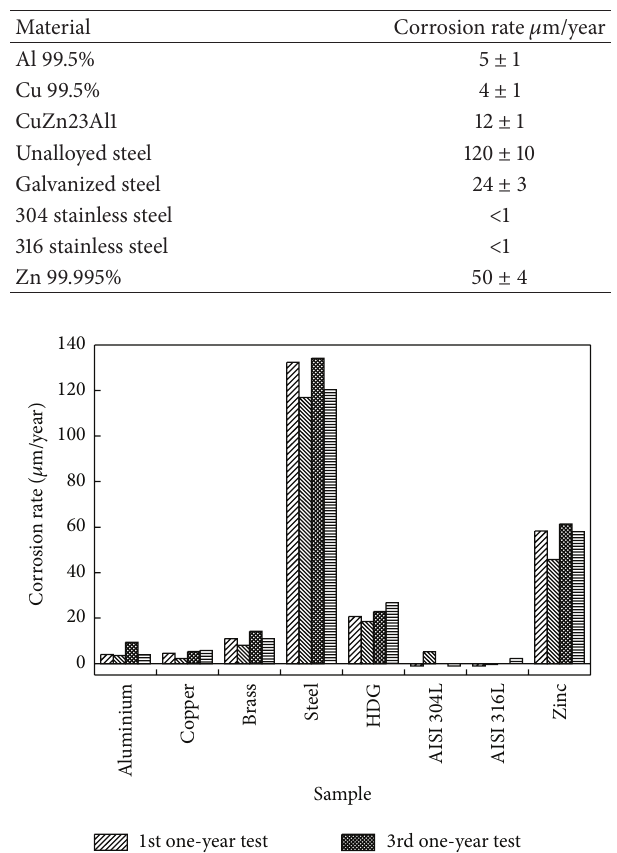
Table 4: Results of planned interval immersion test in Isosaari brackish water, average values from all tests.